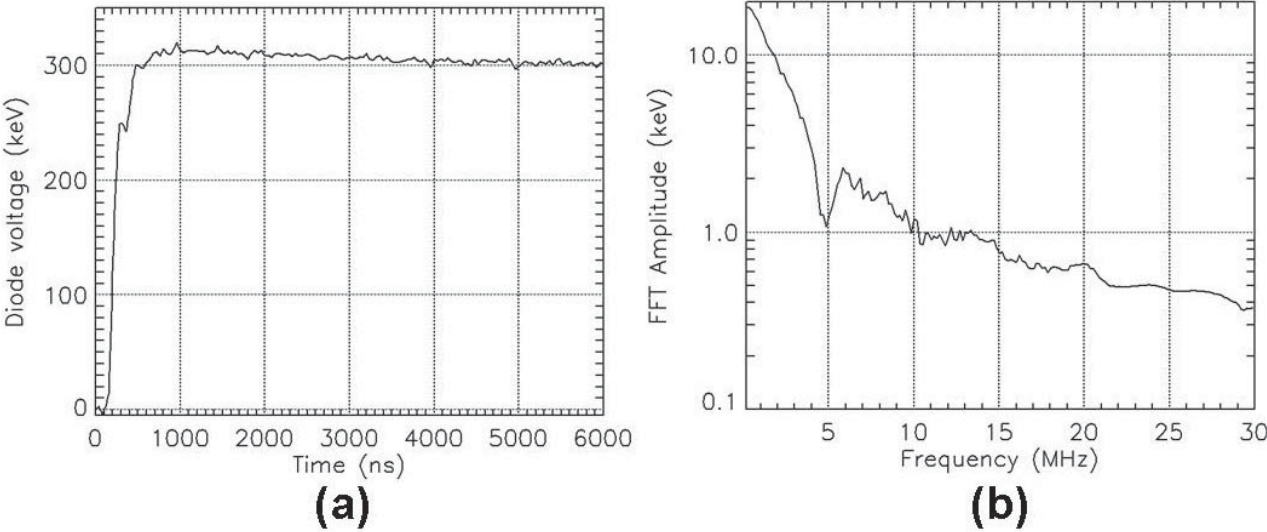
FIG. 2. A measured 5-shot average of the NDCX Marx voltage is shown in (a) with a fast Fourier transform of the waveform in